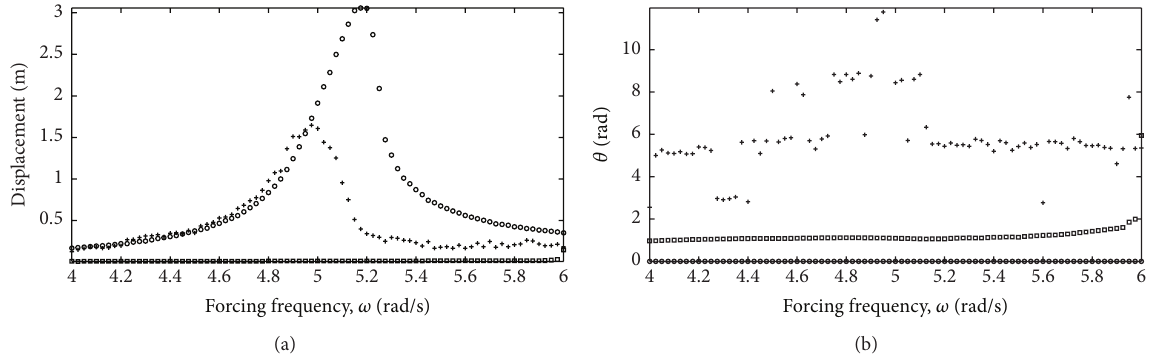
Figure 9: Frequency response curves for 𝑘 = 𝐼 𝑜 𝜔 2 𝑛 /2 = 6.4 Nm / rad and 𝑐 opt = 𝐼 𝑜 𝜔 2 𝑛 /4𝜔 𝑔 = 0.9 Nms / rad: tip response of beam (a); gyro response (b) for (o) Ω = 0 rpm, (+) Ω = 7500 rpm, and ( ◻ ) Ω = 10000 rpm with the base excitation of 𝑧 = 0.05 cos (𝜔𝑡) .